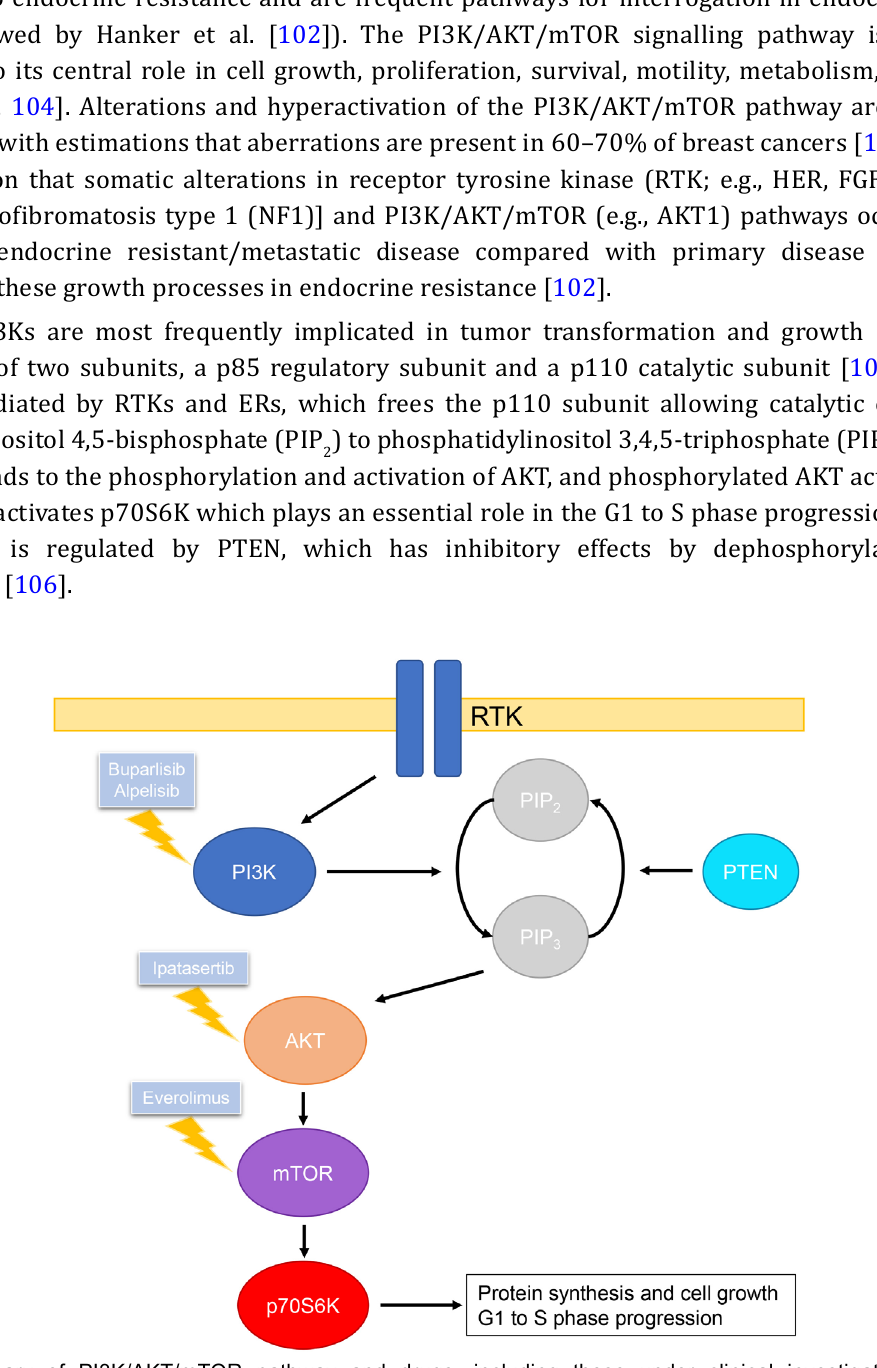
Figure 3. Summary of PI3K/AKT/mTOR pathway and drugs, including those under clinical investigation, that inhibit relevant targets